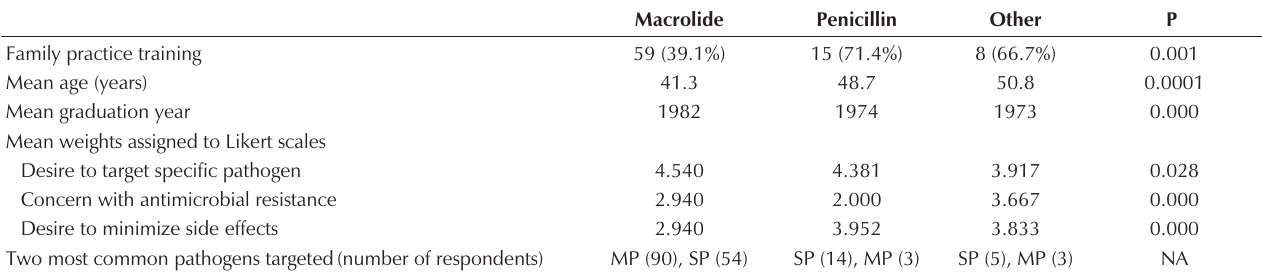
TABLE 3 Factors found to be significant correlates with respondent choice of antibiotic for case 1 – A 17-year-old, previously healthy patient with nonsevere clinical presentation